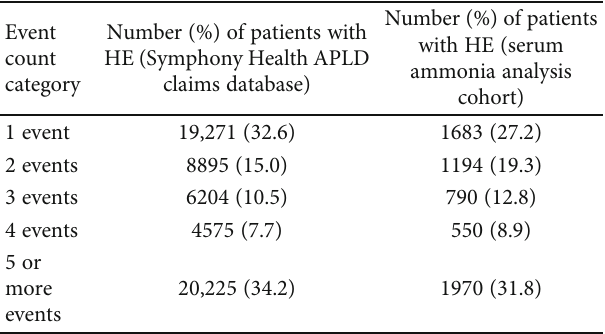
Table 5: Proportion of HE patients with HE